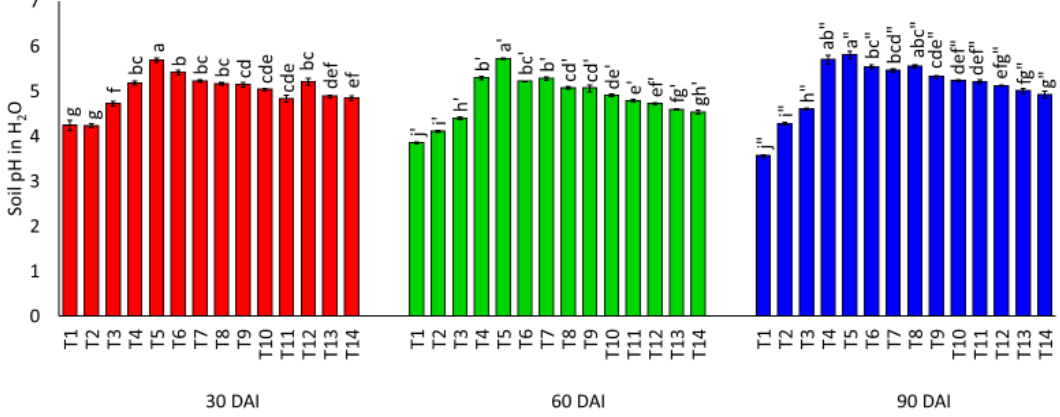
Figure 3. Effects of treatments on soil pH in water after thirty, sixty, and ninety days of incubation, where T1: soil alone, T2: Egypt rock phosphate alone, T3: Egypt rock phosphate + 100% charcoal, T4: Egypt rock phosphate + 100% sago bark ash, and T5: Egypt rock phosphate + 100% charcoal + 100% sago bark ash, T6: Egypt rock phosphate + 75% charcoal + 75% sago bark ash, T7: Egypt rock phosphate + 50% charcoal + 75% sago bark ash, T8: Egypt rock phosphate + 25% charcoal + 75% sago bark ash, T9: Egypt rock phosphate + 75% charcoal + 50% sago bark ash, T10: Egypt rock phosphate + 50% charcoal + 50% sago bark ash, T11: Egypt rock phosphate + 25% charcoal + 50% sago bark ash, T12: Egypt rock phosphate + 75% charcoal + 25% sago bark ash, T13: Egypt rock phosphate + 50% charcoal + 25% sago bark ash, and T14: Egypt rock phosphate + 25% charcoal + 25% sago bark ash. Means with different letter(s) within the same incubation period indicate significant differences between treatments according to Tukey’s HSD test at p ≤ 0.05, i.e., a > b > c. Bars represent the mean values ± SE.